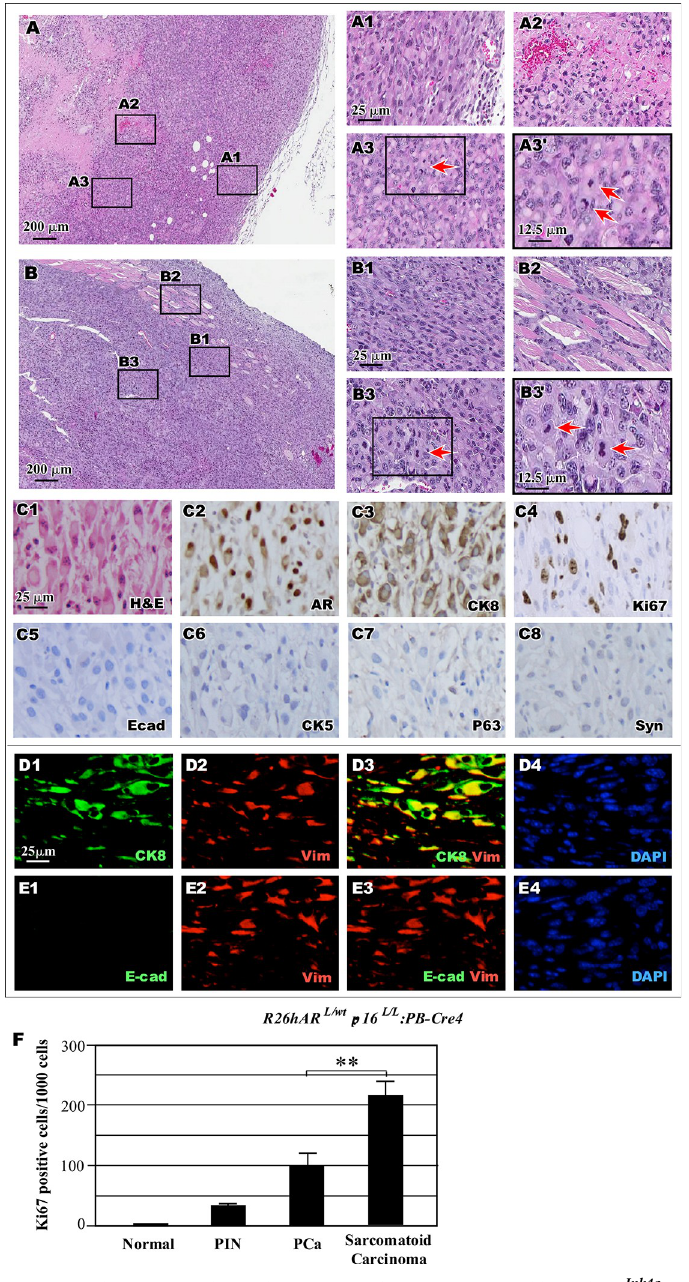
Fig 4. Simultaneous conditional expression of AR transgene and loss of p16 Ink4a expression induce sarcomatoid carcinoma development. (A-B) Representative images of two tumor samples display the region of sarcomatoid carcinoma. Scale bar = 200 μ m. Representative images of different lesions are shown, including sarcomatoid carcinoma (A1, B1), area of necrosis (A2), invasion into muscle (B2), and images of mitotic figures (A3, B3, see the arrows). (C) Representative H&E and IHC images from the R26hAR L/wt : p16 L/L : PB-Cre4 mice were shown for staining with different antibodies as labeled in the right bottom corner. (D-E) Co-IF from the R26hAR L/wt : p16 L/L : PB-Cre4 mice of secretory epithelial cell marker CK8 (green), mesenchymal cell marker vimentin (red), and DAPI (blue), upper panels; Co-IF of secretory epithelial cell marker E-cadherin (green) and mesenchymal cell marker vimentin (red) and DAPI (blue), lower panels. F. R26hAR L/wt : p16 L/L : PB-Cre4 mouse tissues were stained and quantified for Ki67 for the above tissues were measured in total 1,000 epithelial cells. Representative data shows mean and standard deviation. �� p < 0.005 Scale bar = 25 μ m and magnifications were at 12.5 μ m (A1-E4).